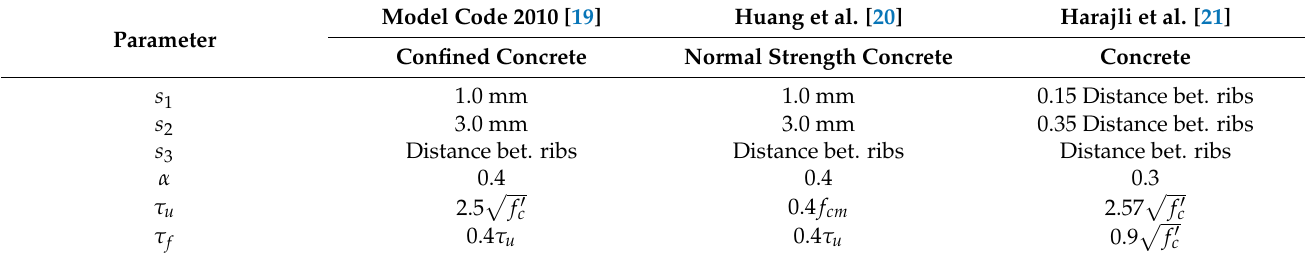
Figure 1. Analytical bond stress–slip relationship (CEB-FIP Model Code 2010). Table 1. The parameter values for the prediction models for the bond stress–slip relationship.